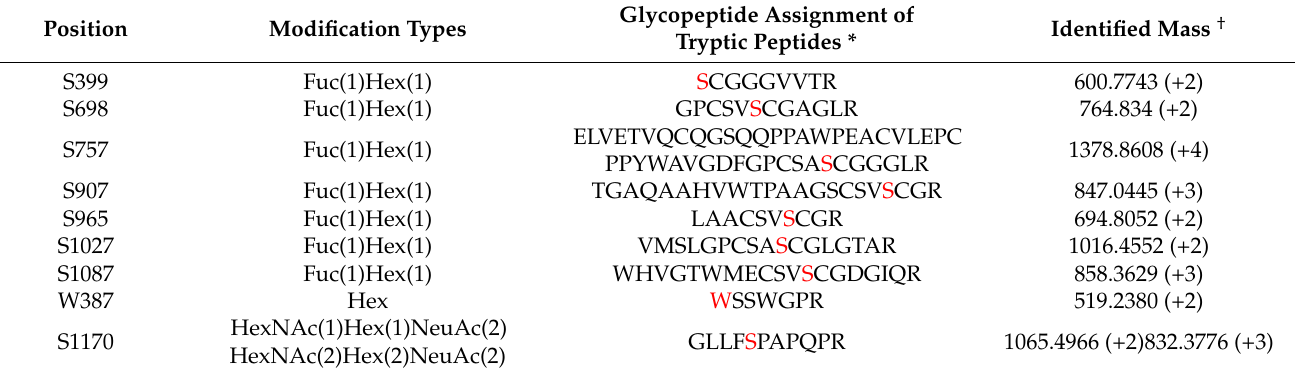
Table 4. O -fucosylation and C -mannosylation of flask-derived V5-tagged purified